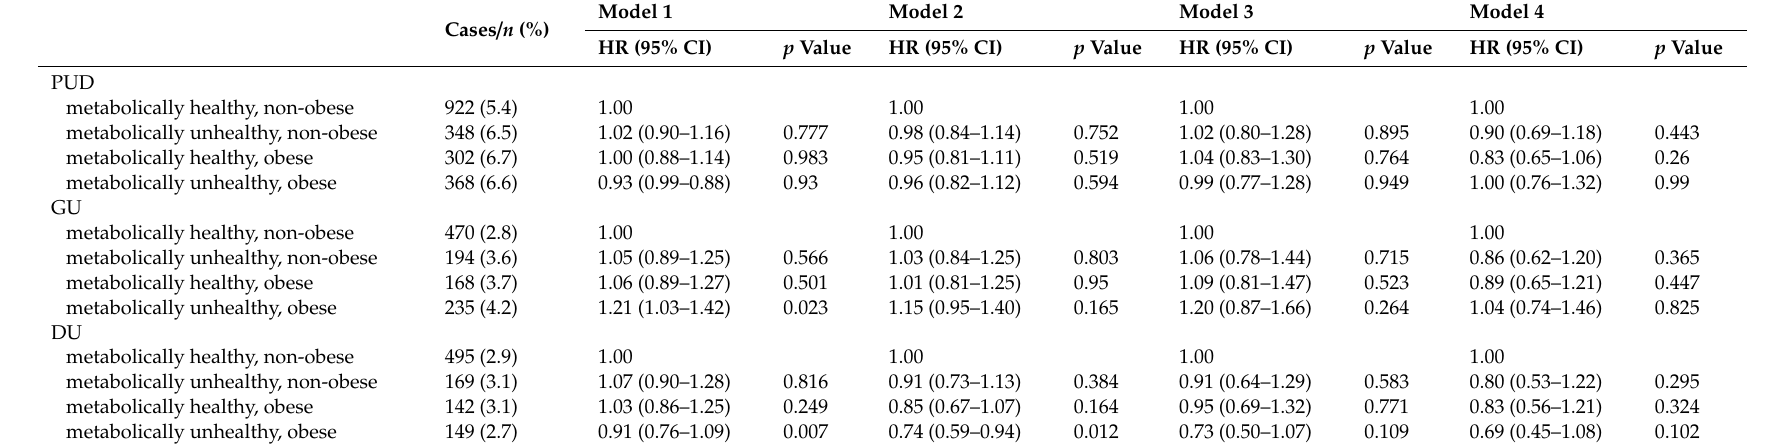
Table 3. Association between metabolic health, obesity, and peptic ulcer